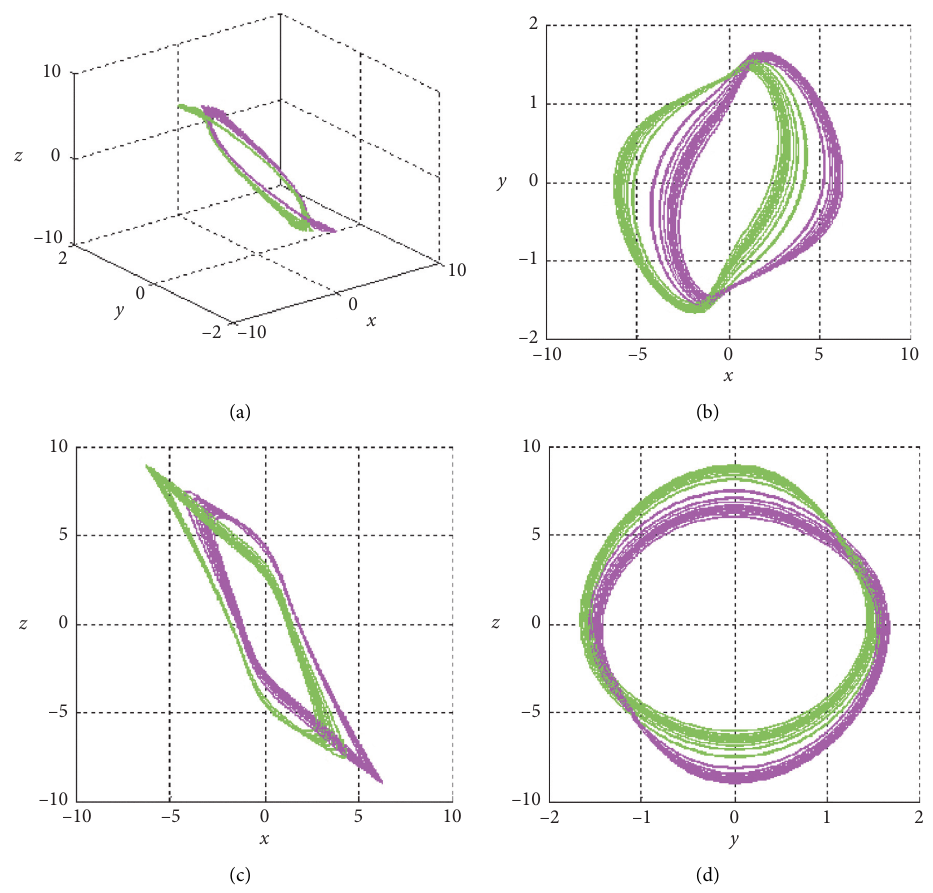
Figure 1: Phase diagrams of system (1); initial values: (5.9 0.3720 − 8.4291) (magenta) and ( − 5.9 − 0.3720 8.4291)